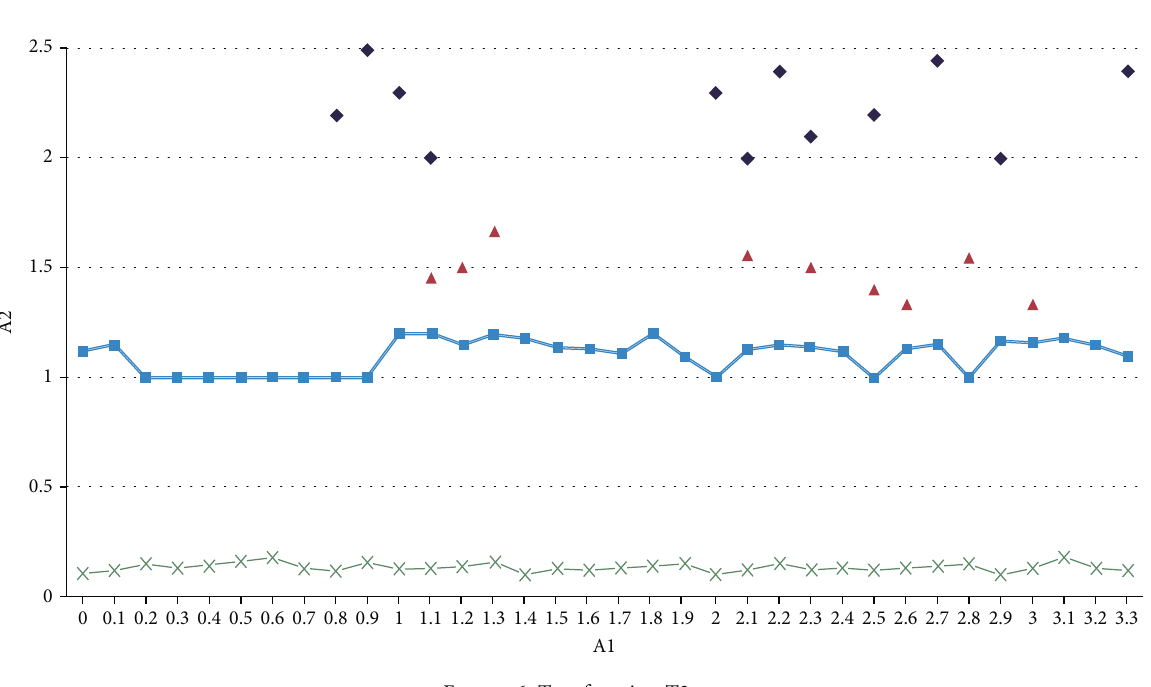
Figure 5: Test function T2.